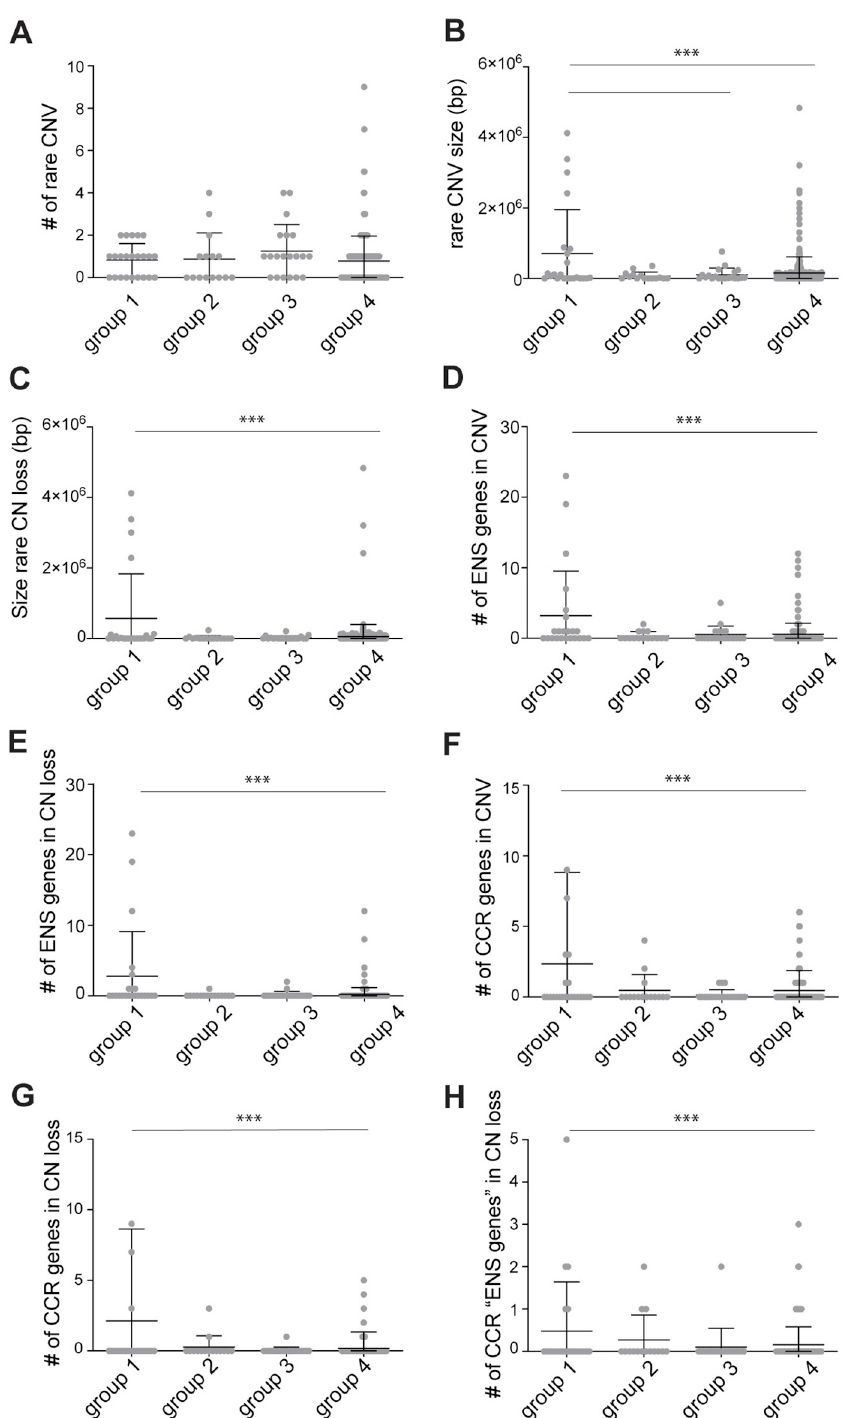
Fig 2. Copy Number Variation analysis of HSCR patients and controls. (A) Graph showing the number of rare CNVs found in the four groups. No statistical differences were found. (B) Graph showing the size in base pairs (bp) of the rare CNVs found in the four groups. Rare CNV size in group 1 (HSCR-AAM) was significantly larger than those found in group 3 (HSCR without a causal variant identified) and group 4 (controls). (C) Graph showing the size (bp) of the rare CN losses found in the four groups. Rare CN loss size in group 1 (HSCR-AAM) was significantly larger than those found in group 4 (controls). (D) Graph showing the number of “ENS genes” included in the CNVs found in the